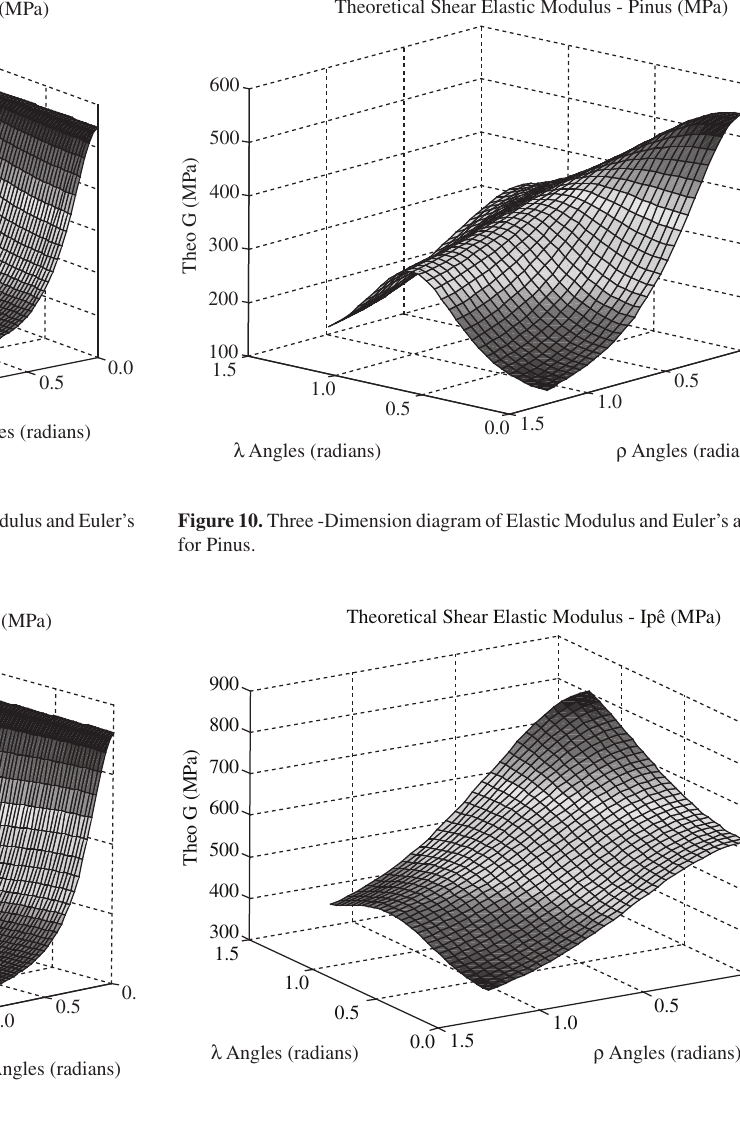
Figure 11. Three -Dimension diagram of Shear Elastic Modulus and Euler’s angle for